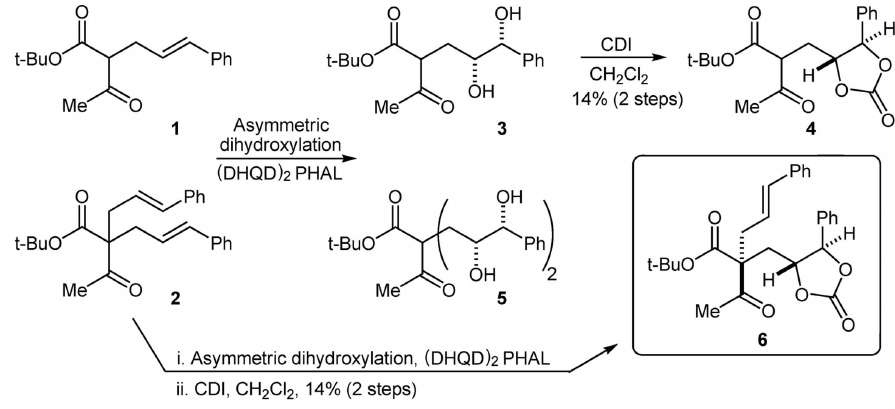
Summary of the synthetic procedure. CDI = 1,1′-carbonyldiimidazole, (DHQD)